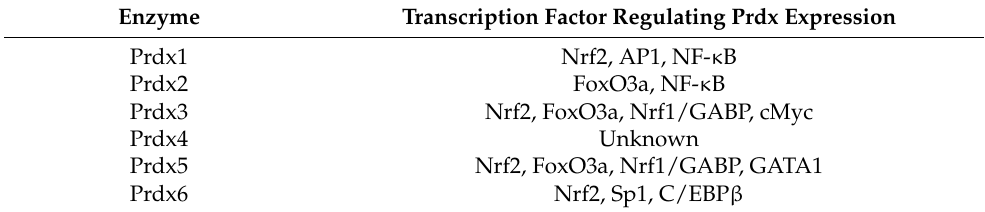
Table 2. Transcription factors that control the expression of peroxiredoxins. Enzyme Transcription Factor Regulating Prdx